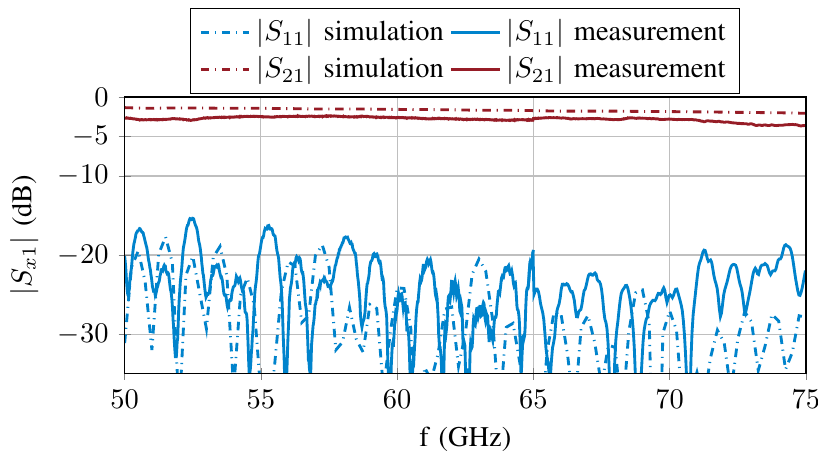
Figure 22. Simulated and measured S-parameters of the PPDW phase shifter.